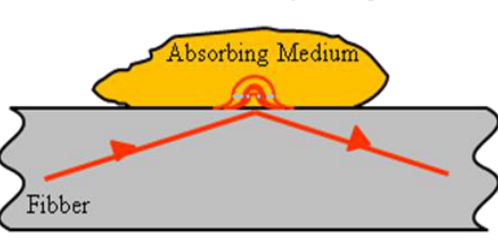
Figure 2. Schematic representation of the experimental set up used for FEWS